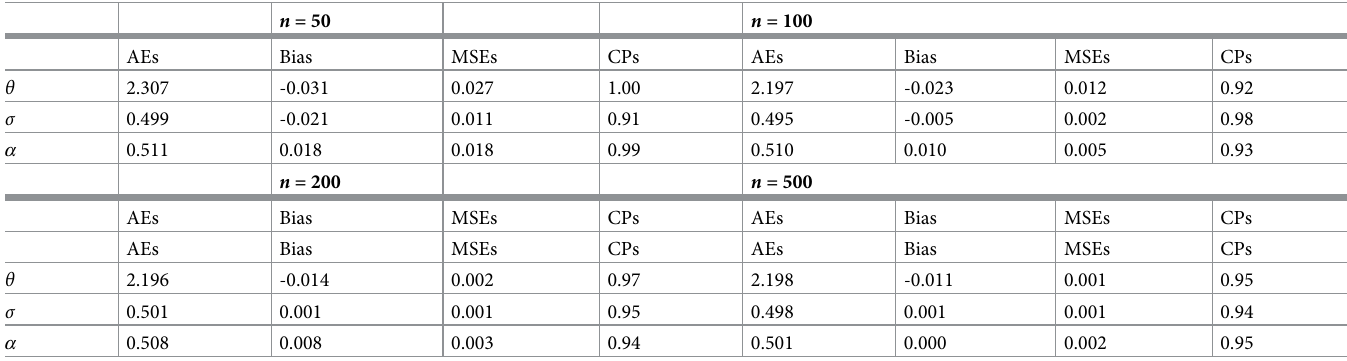
Table 5. AEs, Biases, MSEs and CPs for